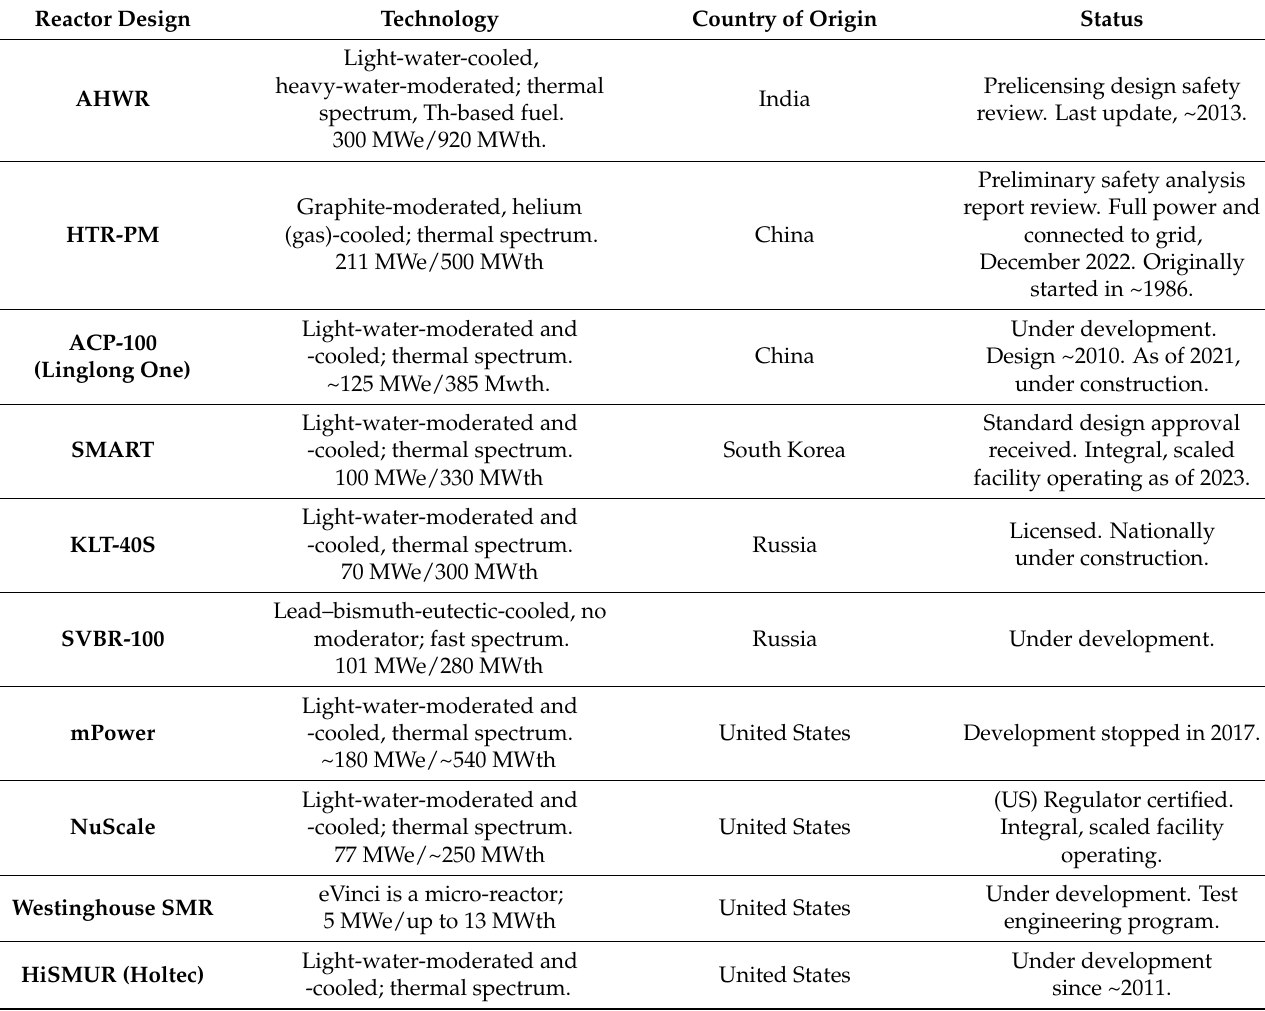
Table 2. Major nuclear countries’ design and licensing progress. Adapted from